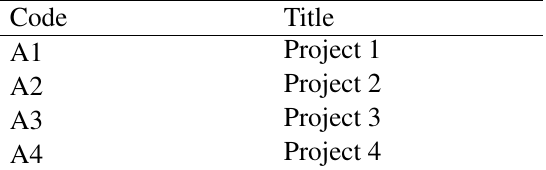
Table 3 Desired options for investment